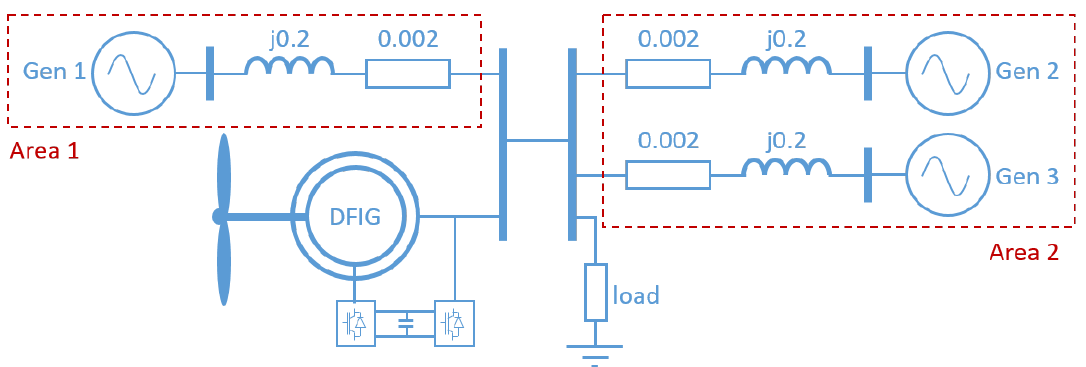
Figure 2. Two-area network used in